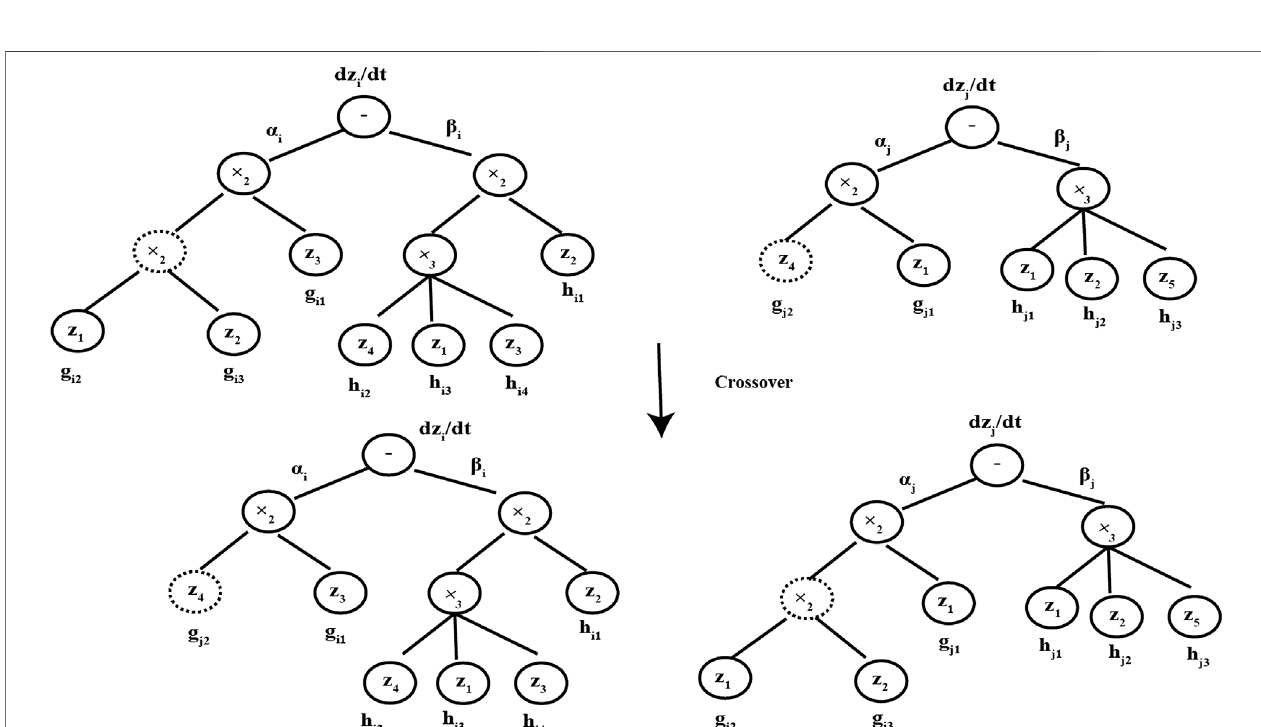
FIGURE 2 | Crossover